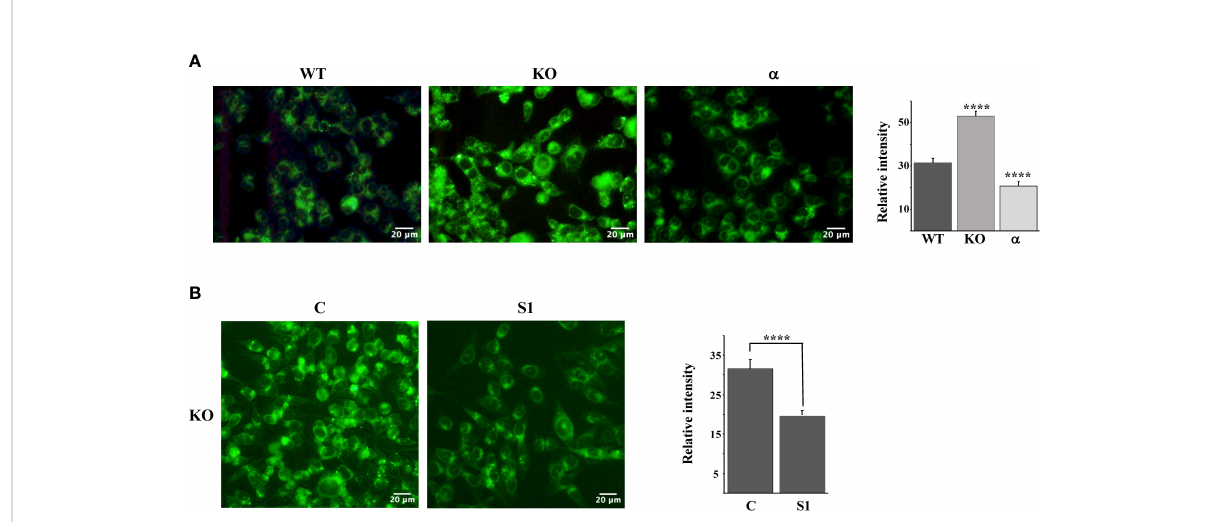
FIGURE 4 Fbw7 controls the accumulation of neutral lipids. (A) HCT116 cells, either wild-type ( WT ), Fbw7 knockout ( KO ), or the same cells reconstituted with Fbw7 a ( a ) were fi xed and stained with LipidTOX Green neutral lipid stain. The mean fl uorescence intensities -/+ SD across each experimental group are provided in the bar graph. (B) Fbw7 knockout ( KO ) HCT116 cells were transduced with control ( C ) or SREBP1 ( S1 ) shRNA, fi xed and stained with LipidTOX Green neutral lipid stain. The mean fl uorescence intensities -/+ SD across each experimental group are provided in the bar graph. P- values lower than 0.05 were considered statistically signi fi cant. *P < 0.05, **P < 0.01, ***P < 0.001, and ****P < 0.0001. NS , not signi fi